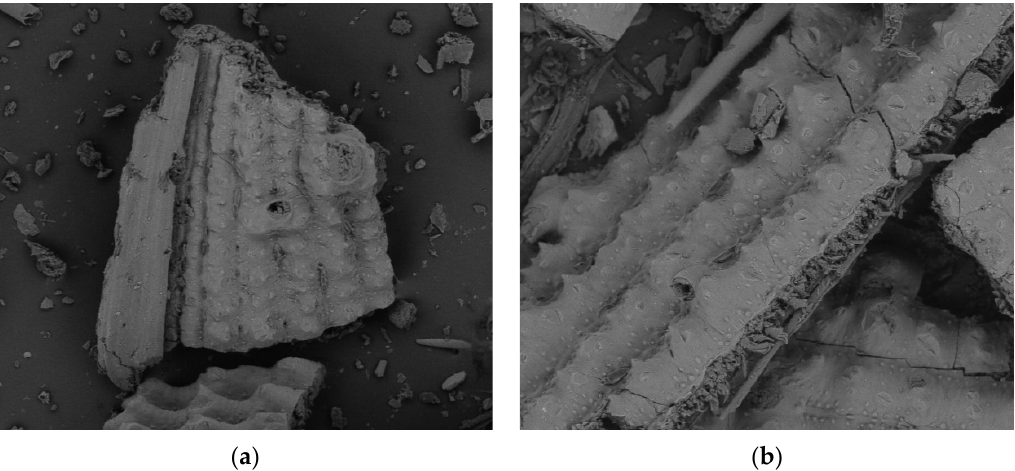
Figure 3. Rice husk micrographs: ( a ) 400× and ( b ) 500× magnification.